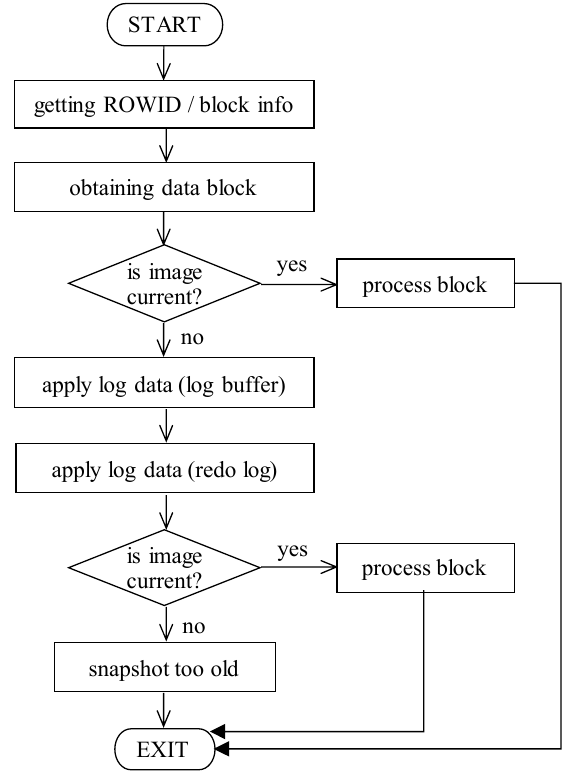
Sensors 2020 , 20 , 1848 Figure 11. Process of block data reconstruction. Figure 11. Process of block data reconstruction.